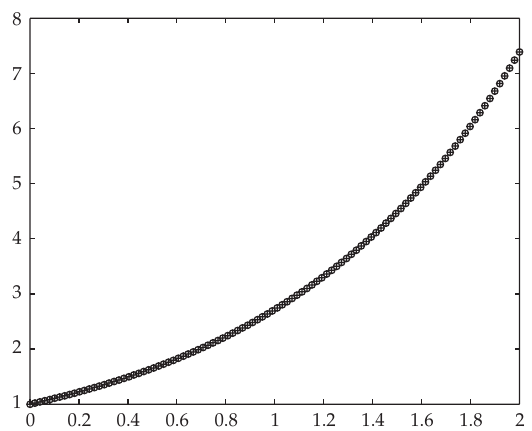
Figure 10: Index 3, T (cid:8) 2, the u -coordinate, “o”-original, “ (cid:9)